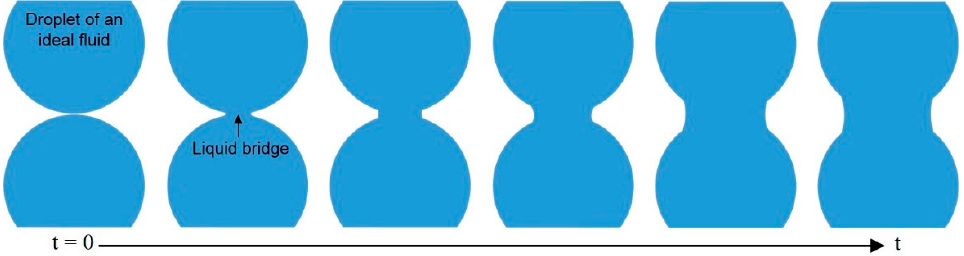
Figure 4. Schematic of the time evolution of the liquid bridge connecting two droplets.